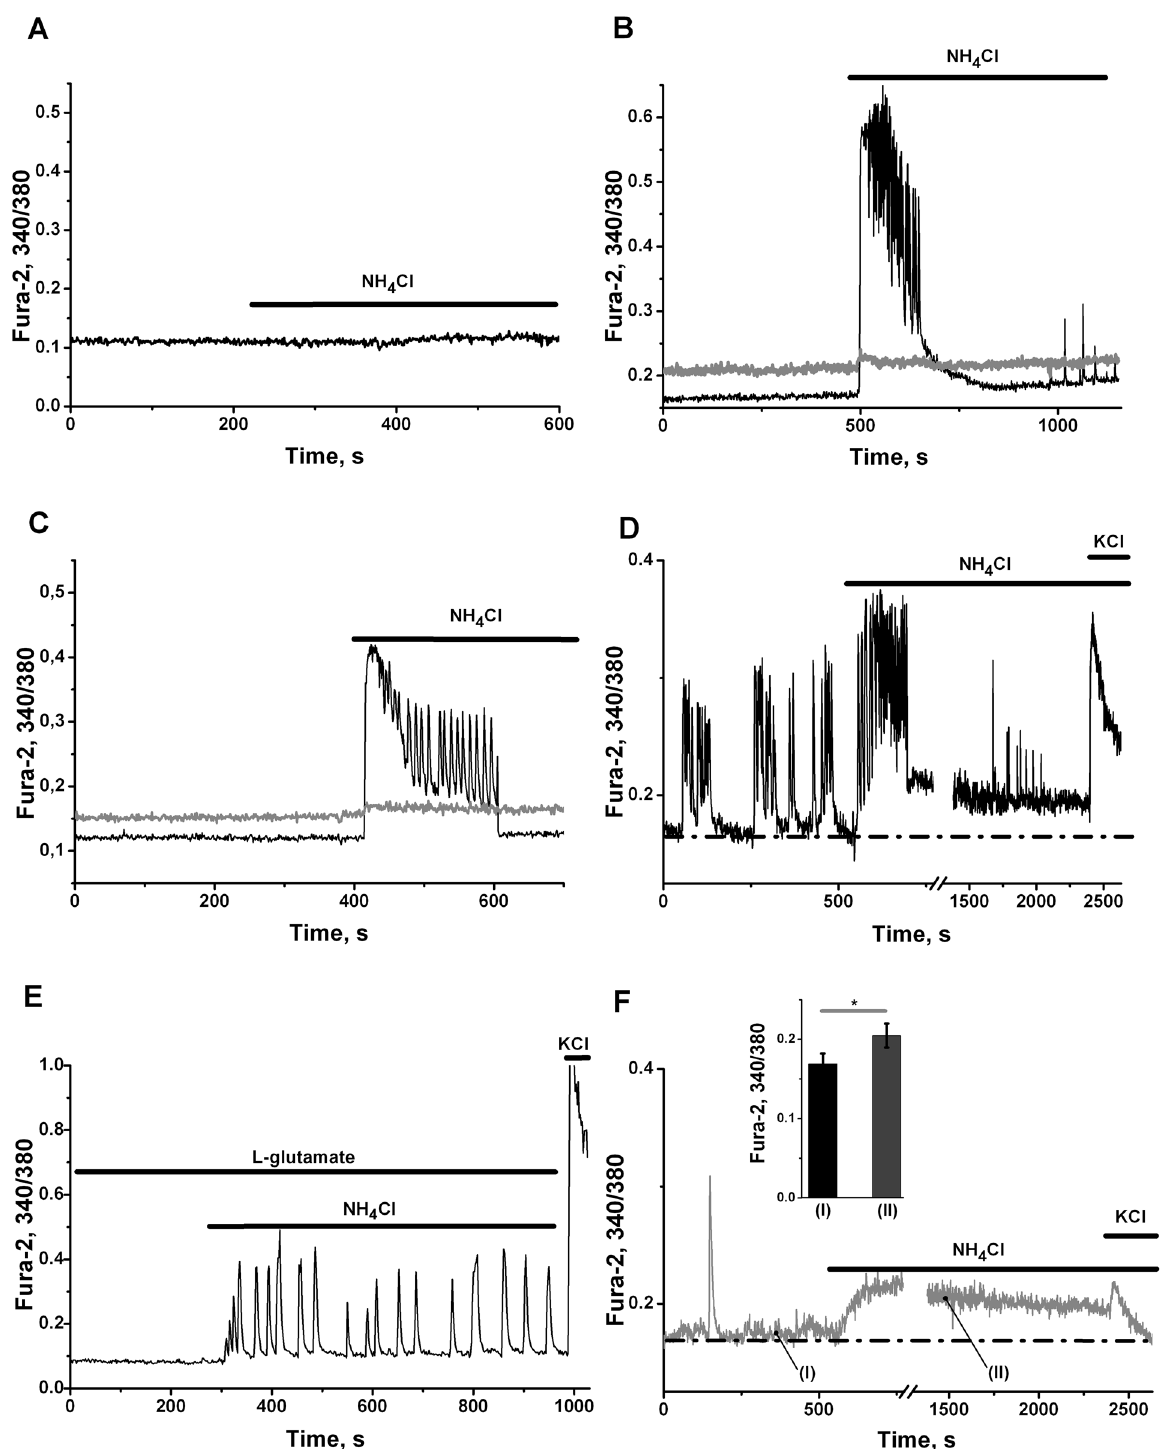
Fig 1. Ammonium chloride effects on neuronal network are concentration dependent. Here and later on calcium responses are measured by Fura-2 ratio. Records characterize individual neurons (black lines) and astrocytes (grey lines), i.e. representative cells of 90 – 95% cells implicated in the network. Thick horizontal black lines mark the periods of application of ammonium chloride (NH 4 Cl, 0.1 – 4 mM), L-glutamate (200 nM) and KCl (35 mM). (A) Application of 0.1 mM NH 4 Cl does not alter Ca 2+ signals registered in representative cells: neurone (black line) and astrocyte (grey line). Neuronal culture 12 DIV. Number of monitored neurons in network N = 84 and number of astrocytes N 1 = 47. Here is presented one of 12 experiments (n = 12). (B) Application of